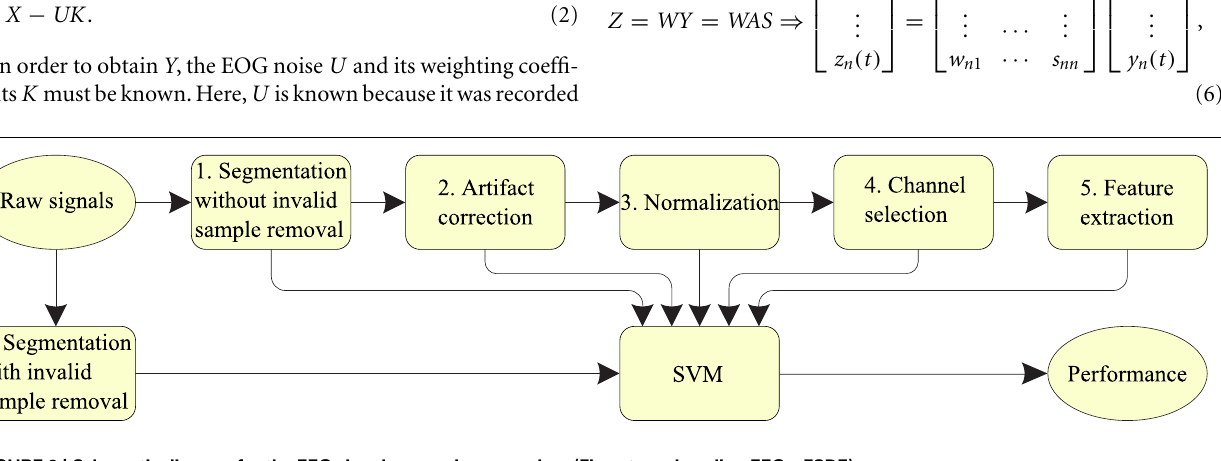
FIGURE 2 | Schematic diagram for the EEG signal processing procedure (Five-stage decoding EEG – FSDE).